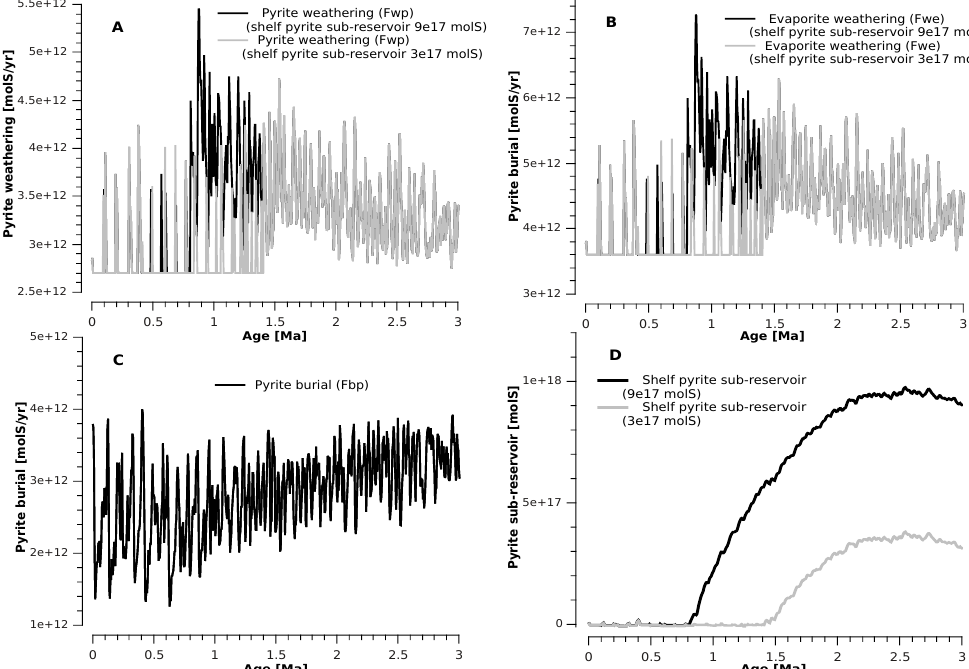
Figure A5. Model forcing with initial fluxes at 200% steady state values. (a) Pyrite weathering ( F wp ). (b) Evaporite weathering ( F we ). (c) Pyrite burial ( F bp ). (d) Pyrite sub-reservoir on the shelf. Note: the pyrite burial flux is not affected by the size of pyrite shelf